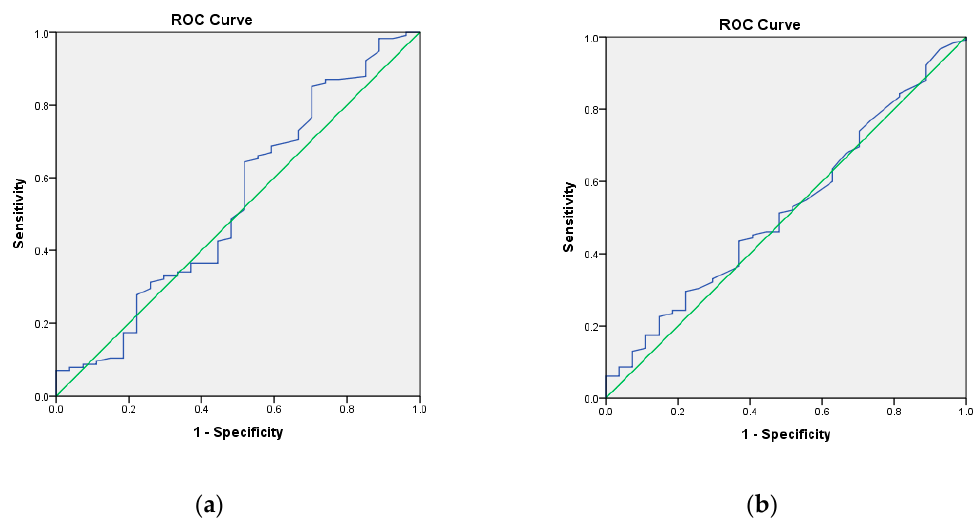
Figure 4. ( a ) Baseline CEC correlation with progression free survival (long versus short); Area under curve (AUC) = 0.533. ( b ) Baseline CD276 + CEC correlation with progression free survival (long versus short); AUC = 0.524.